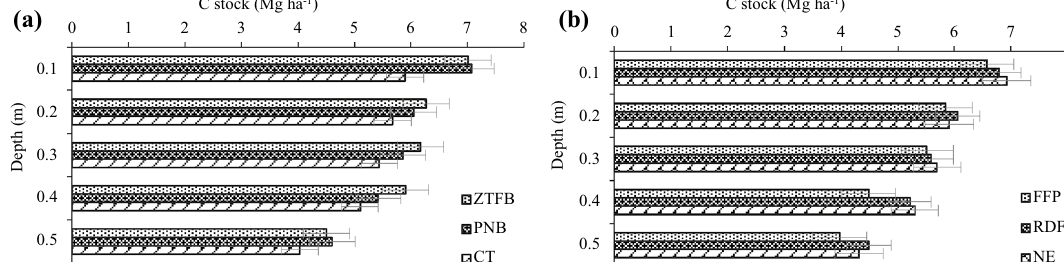
Figure 6. Effect of tillage ( a ) and nutrient management ( b ) on SOC stocks (equivalent soil mass basis) of maize–chickpea rotation. The vertical bars indicate LSD at p =